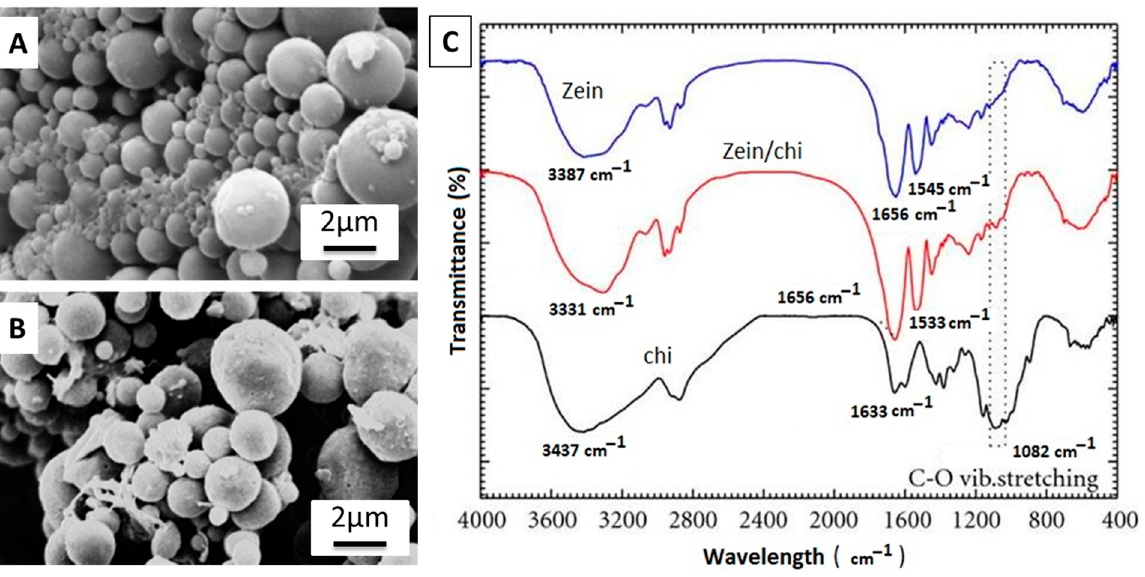
Figure 16. ( A , B ) SEM Images of microparticles of zein and zein/chi, ( C ) FTIR plot of zein, zein/chi, and chi. Reproduced from [147] with permission from Hindawi™.